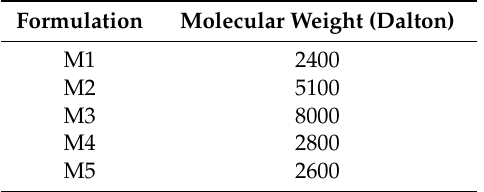
Table 4. Molecular weight (M w ) of the five